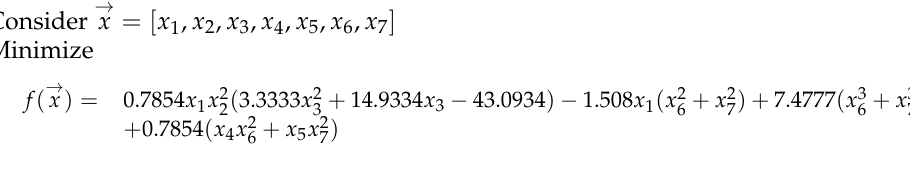
Figure 14. Schematic illustration of speed reducer design problem.